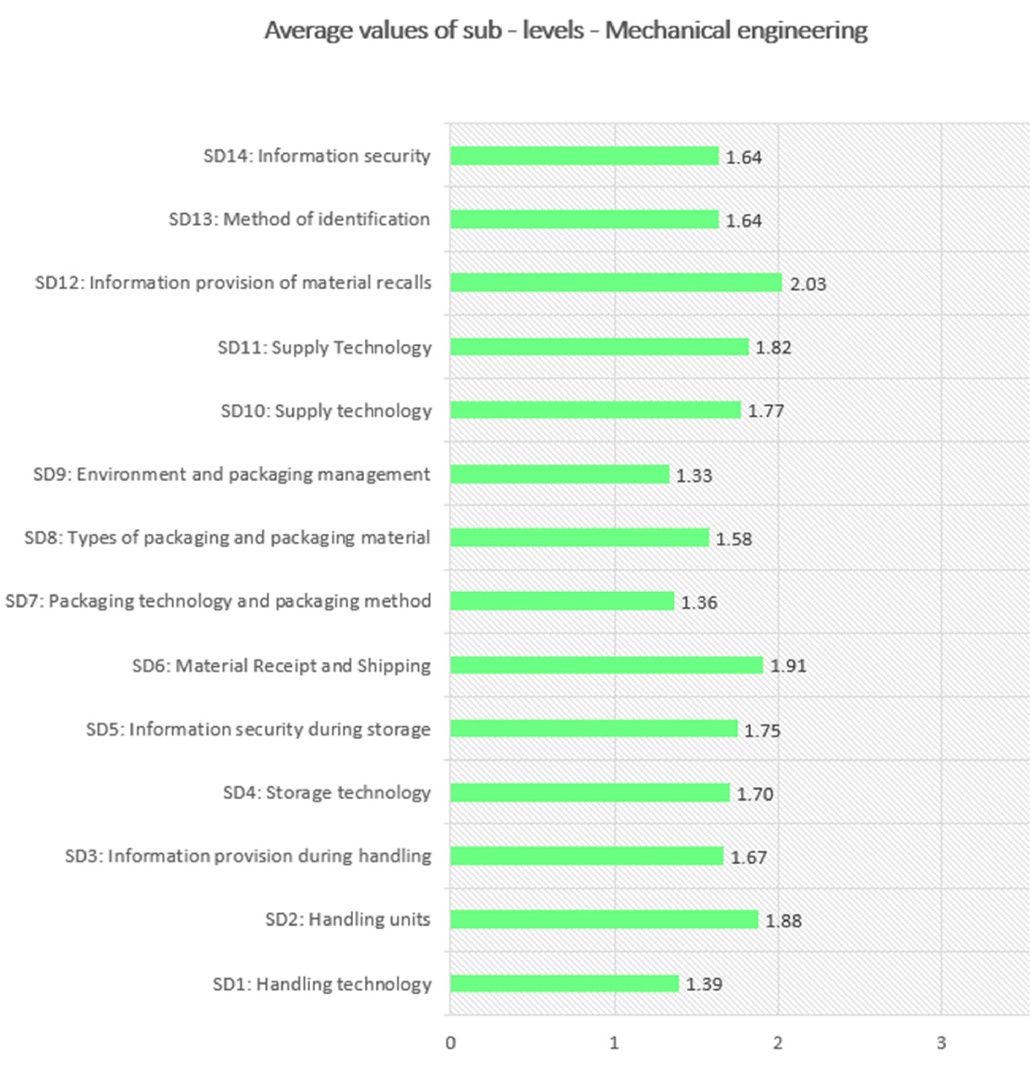
Figure 10. Average values of suspension levels—mechanical engineering.